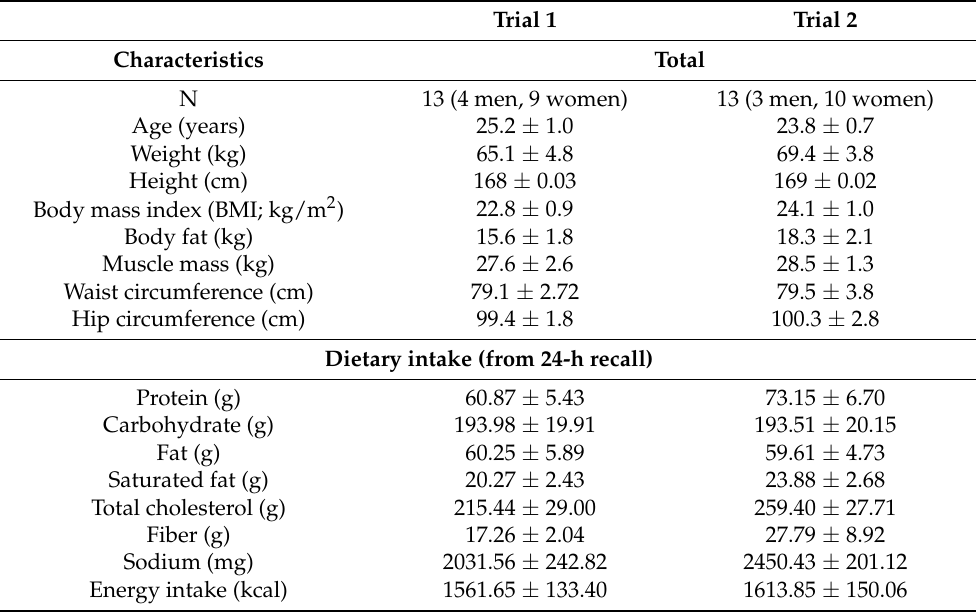
Table 4. Participants’ baseline characteristics in Trials 1 and 2.